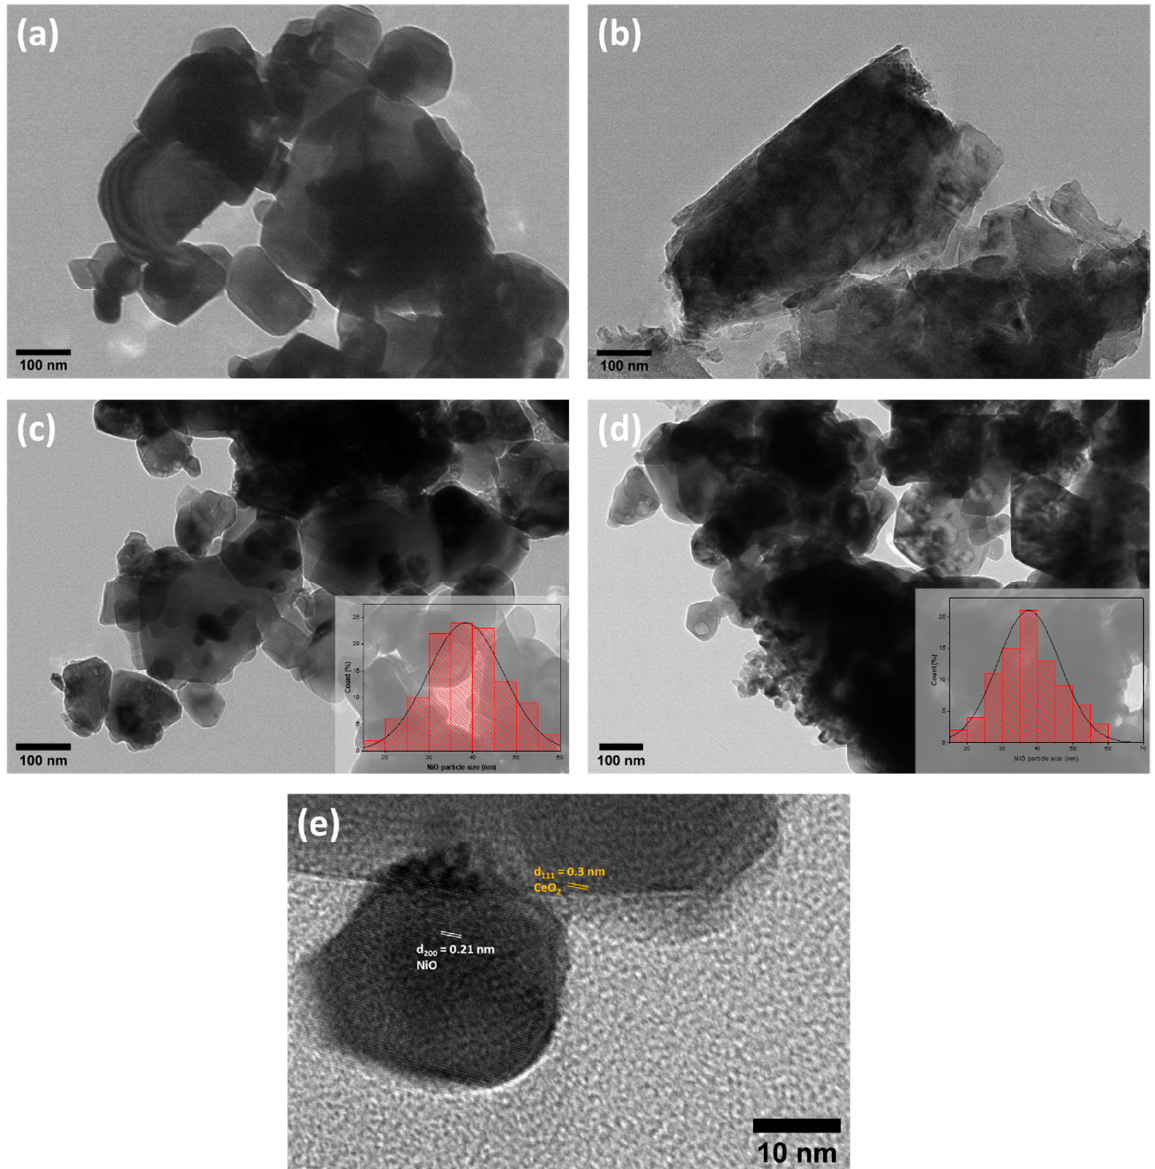
Figure 3. ( a ) TEM image of CeO 2 ; ( b ) TEM image of Al 2 O 3 ; ( c , d ) TEM images and NiO particle size distribution (PSD histograms) of the as-prepared Ni/CeO 2 and Ni/Al 2 O 3 , respectively; ( e ) HRTEM image of Ni/CeO 2 .